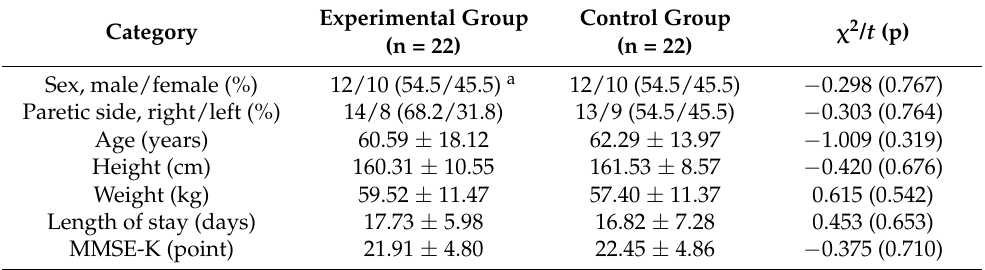
Table 1. General characteristics of study subjects and result of the homogeneity test (N = 44). Experimental Group Category (n =